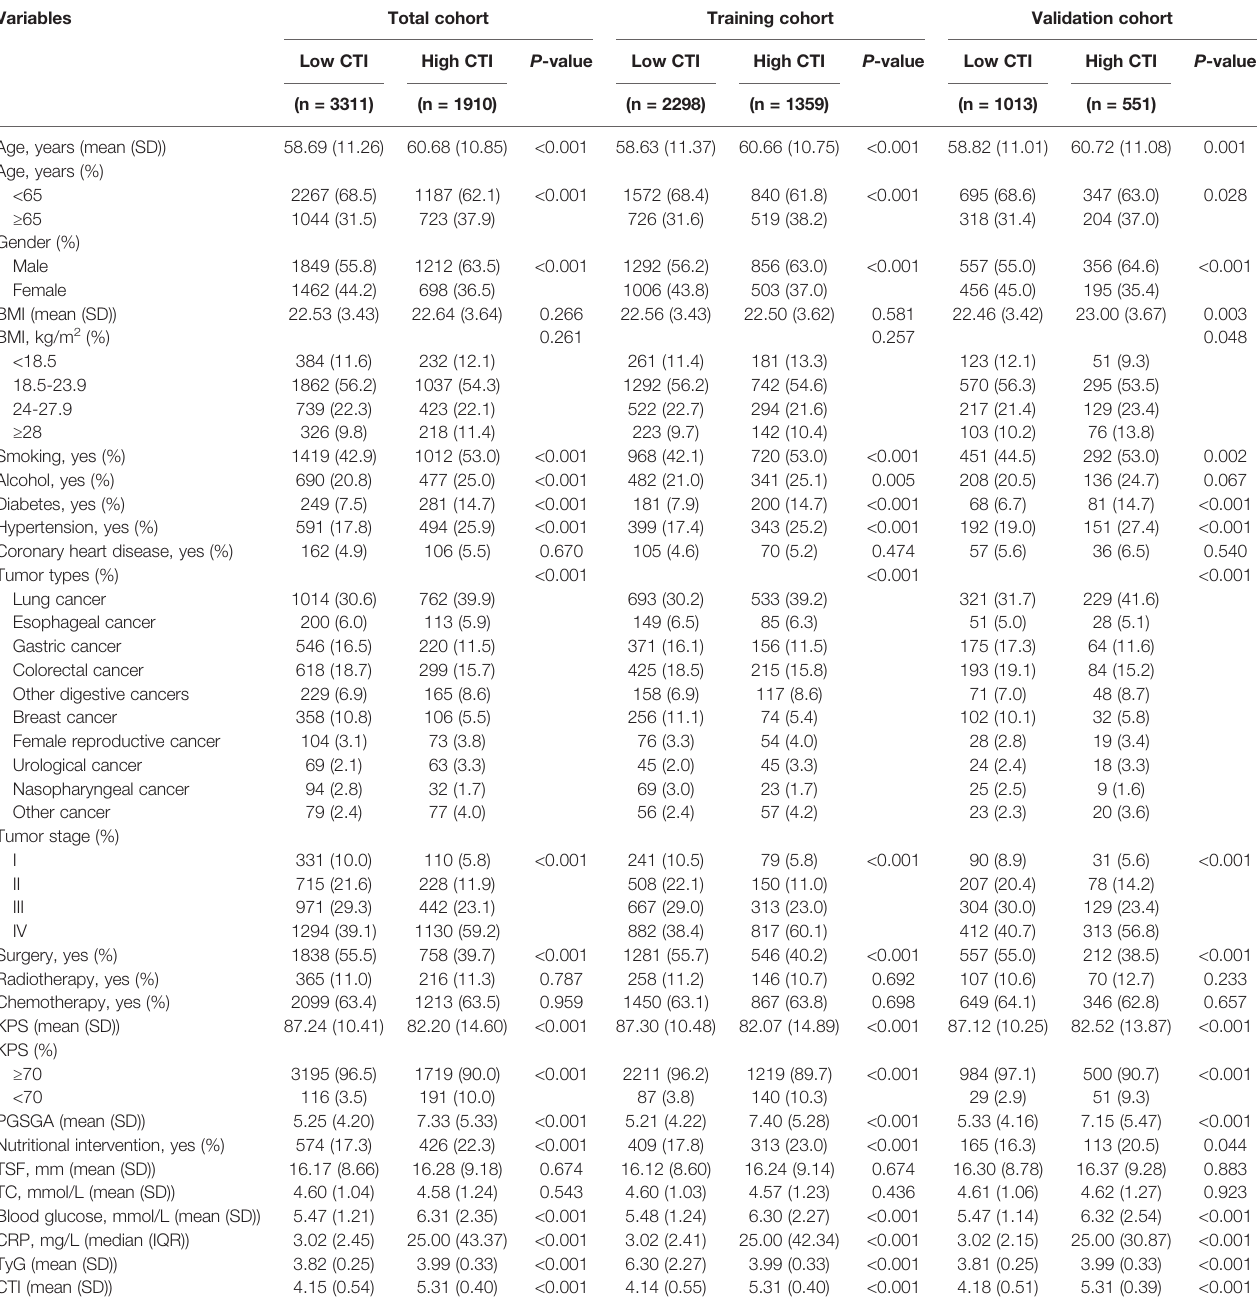
TABLE 2 | Baseline characteristics strati fi ed by